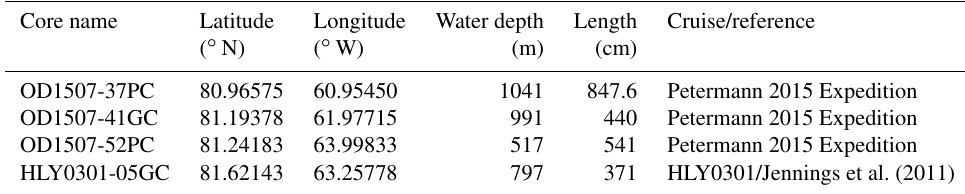
Table 1. Core locations and acquisition information for cores used in seismo-acoustic facies and lithofacies